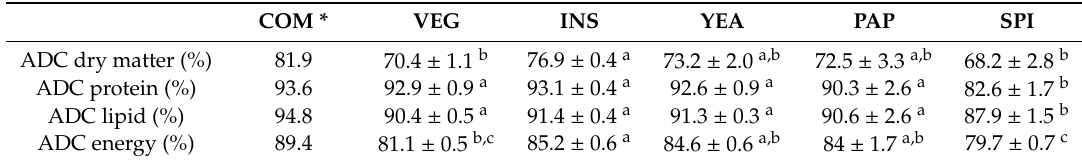
Table 1. Apparent digestibility coe ffi cient (ADC) of the di ff erent feeds tested according to the